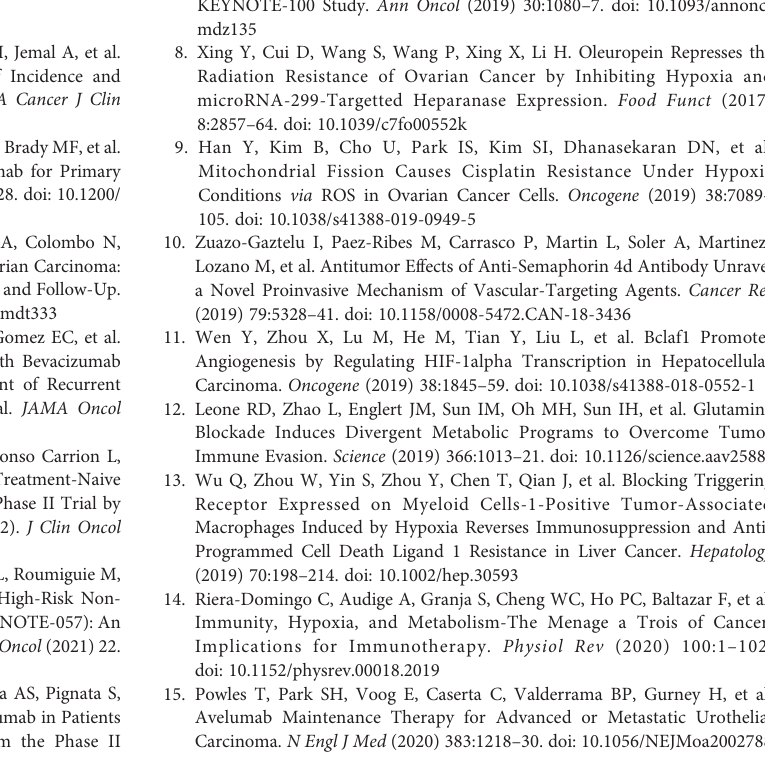
Supplementary Figure 1 | Clustered dendrogram and Scatter plots of the highly correlated modules in different immune cells of OC. (A) Clustered dendrogram of 517 samples. (B) Red module has the highest association with activated mast cells. (C – F) Blue module is highly associated with T cells CD4